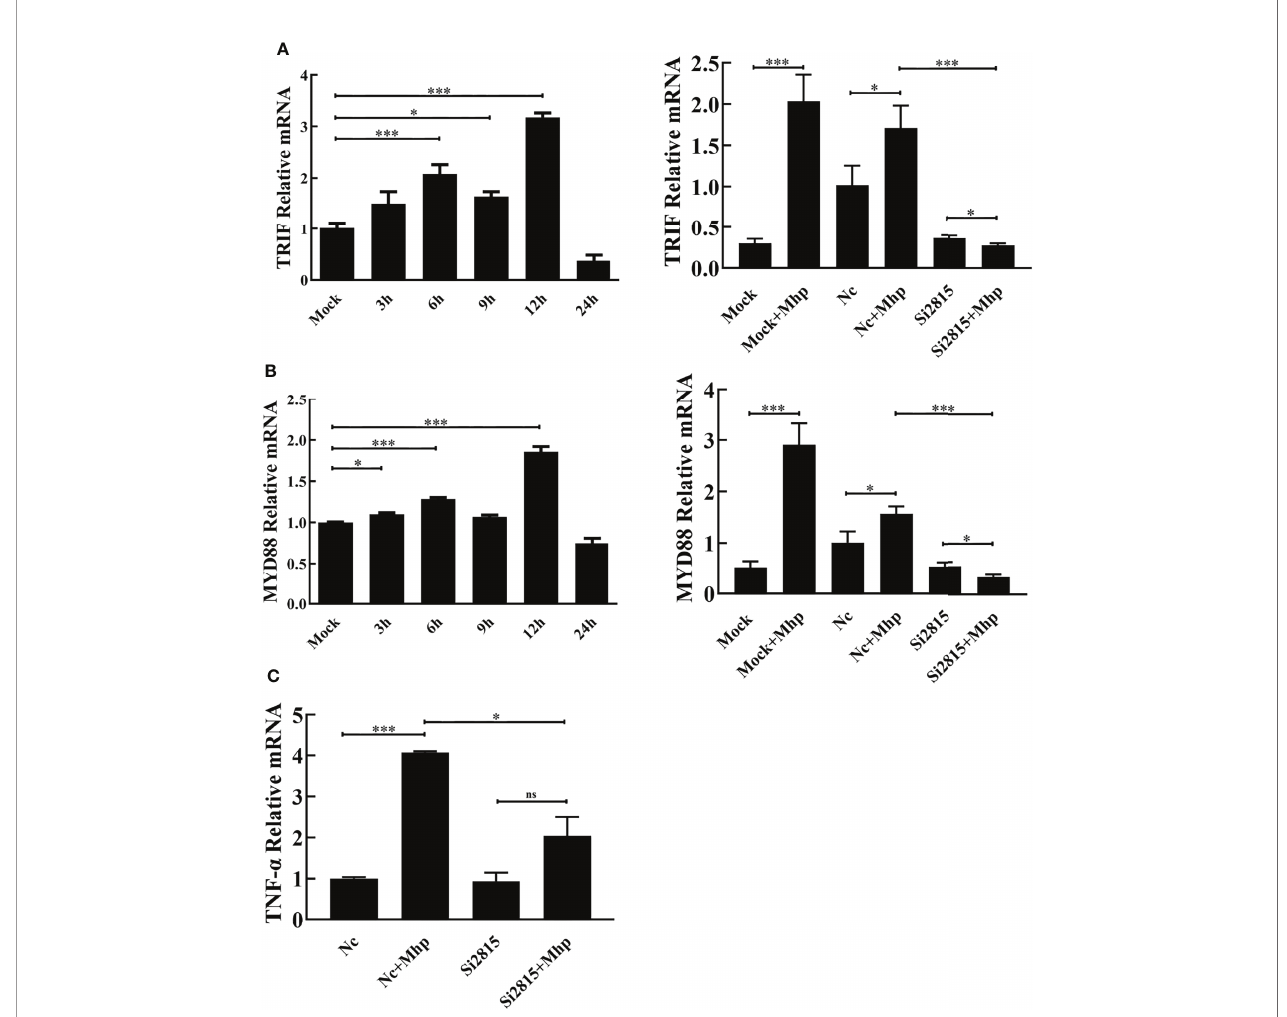
FIGURE 3 | M. hyopneumoniae infection activates NOD1-mediated TRIF and MYD88 signaling pathways. M. hyopneumoniae infection induces TRIF (A) and MYD88 (B) transcription in a time-dependent manner. Alveolar macrophages were infected with M. hyopneumoniae (100 m L, 10 8 CCU) or mock-infected. Cells were collected separately at the indicated time points, and subjected to qRT-PCR to analyze the relative mRNA transcription. Alveolar macrophages were transfected with NOD1 siRNA or NC siRNA for 24 h, and the cells were then mock infected or infected with M. hyopneumoniae (100 m L, 10 8 CCU). The cells were collected at 12 hpi. The MYD88 and TRIF mRNA expression levels were determined by qRT-PCR assay. (C) Knockdown of NOD1 blocked M. hyopneumoniae -induced mRNA expression of TNF- a . Transfection and infection experiments performed as described for panels (A, B) The cells were collected at 12 hpi and subjected to qRT-PCR to determine the mRNA expression. * P < 0.05, and *** P < 0.001 indicate statistically signi fi cant differences among different groups, and ns represents no